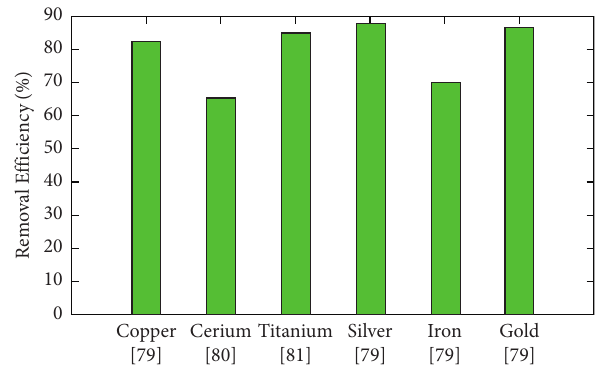
Figure 2: Comparative analysis of removal efficiency (%) for various